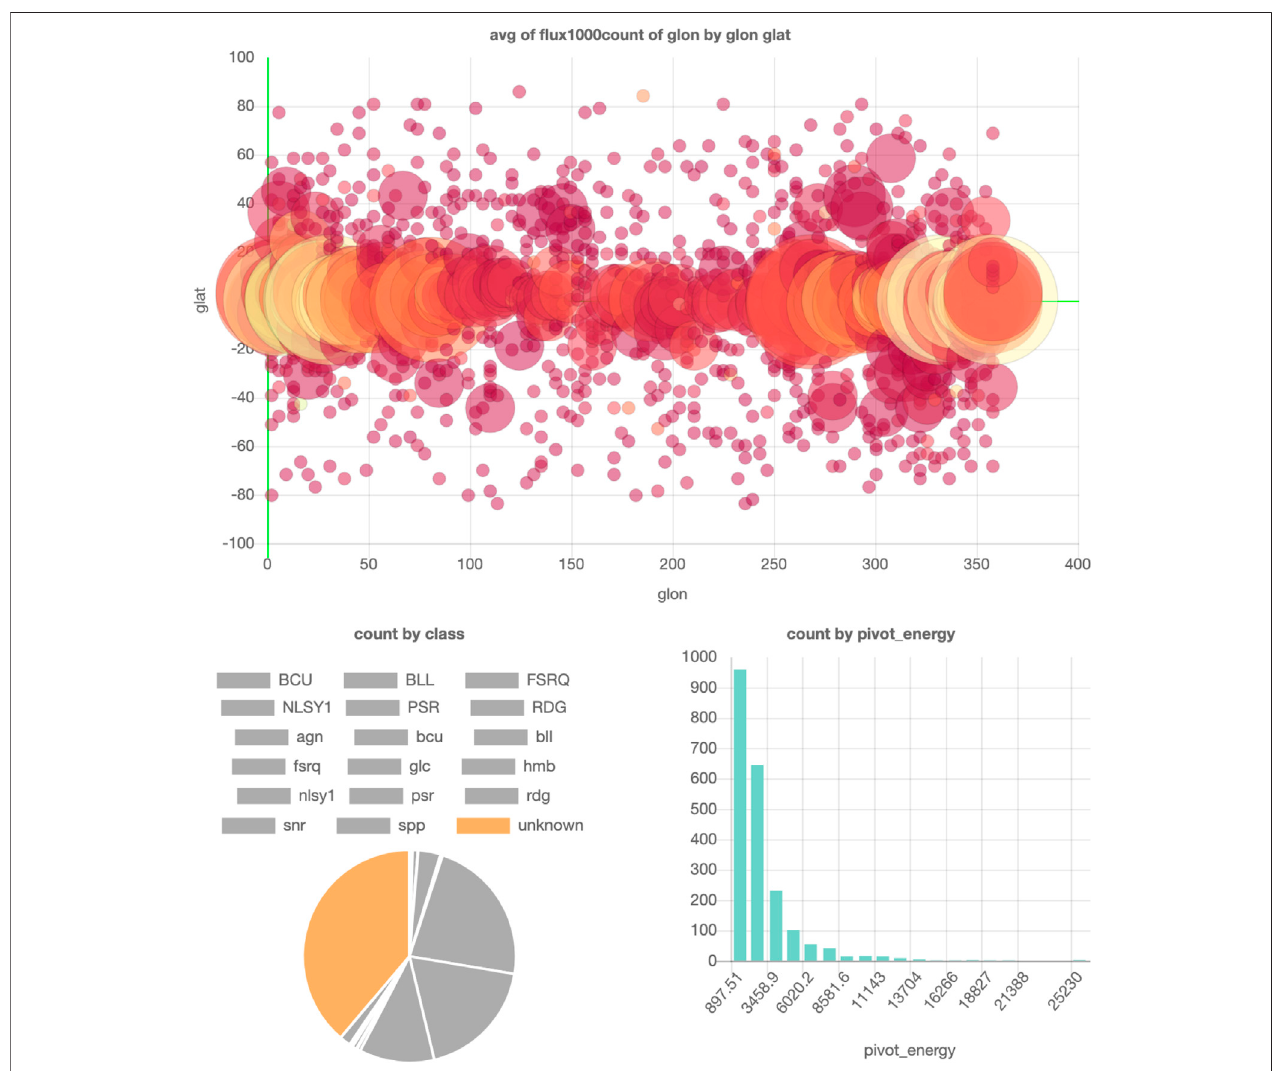
FIGURE 8| SPOT visualization of the FL8Y Fermi Point Source catalog(Fermi, 2018). Parts ofa fi gure can be turned off to fi lter them out in the other fi gures. In this example, all point source classes except the unknown class are turned off, so the locations and pivot energies of only the unknown point sources are shown in the top and bottom right plots. The interactive dashboard of this dataset can be accessed